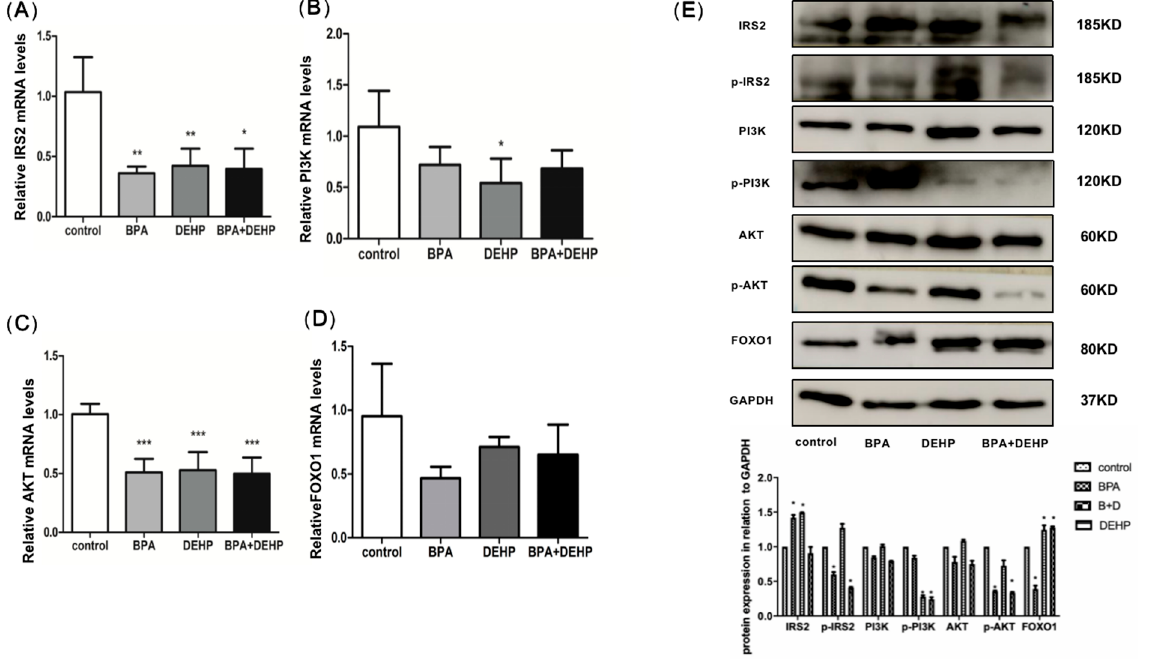
Figure 6. Effect of BPA and DEHP and of their co-exposure-induced mRNA changes in IRS-2 ( A ), PI3K ( B ), AKT ( C ), and FOXO1 ( D ) levels in offspring liver. Effect of BPA group, DEHP group and of their co-exposure induced phosphorylated protein changes in IRS2, PI3K, AKT and FOXO1 levels in offspring liver ( E ). Data are presented as means ± SEM. Data are presented as means ± SEM. [Note]: “*”: p < 0.05, “**”: p < 0.01, “***”: p < 0.001, n = 6.